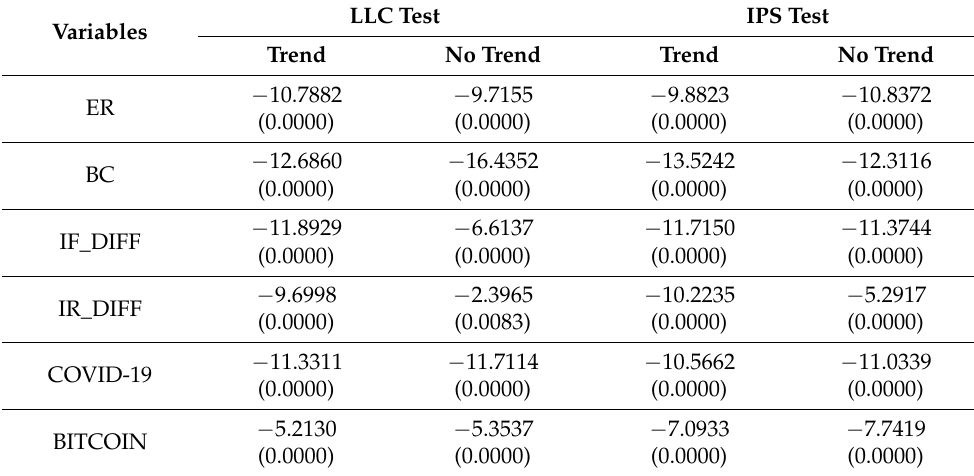
Table 3. Panel unit root test (all specifications include an